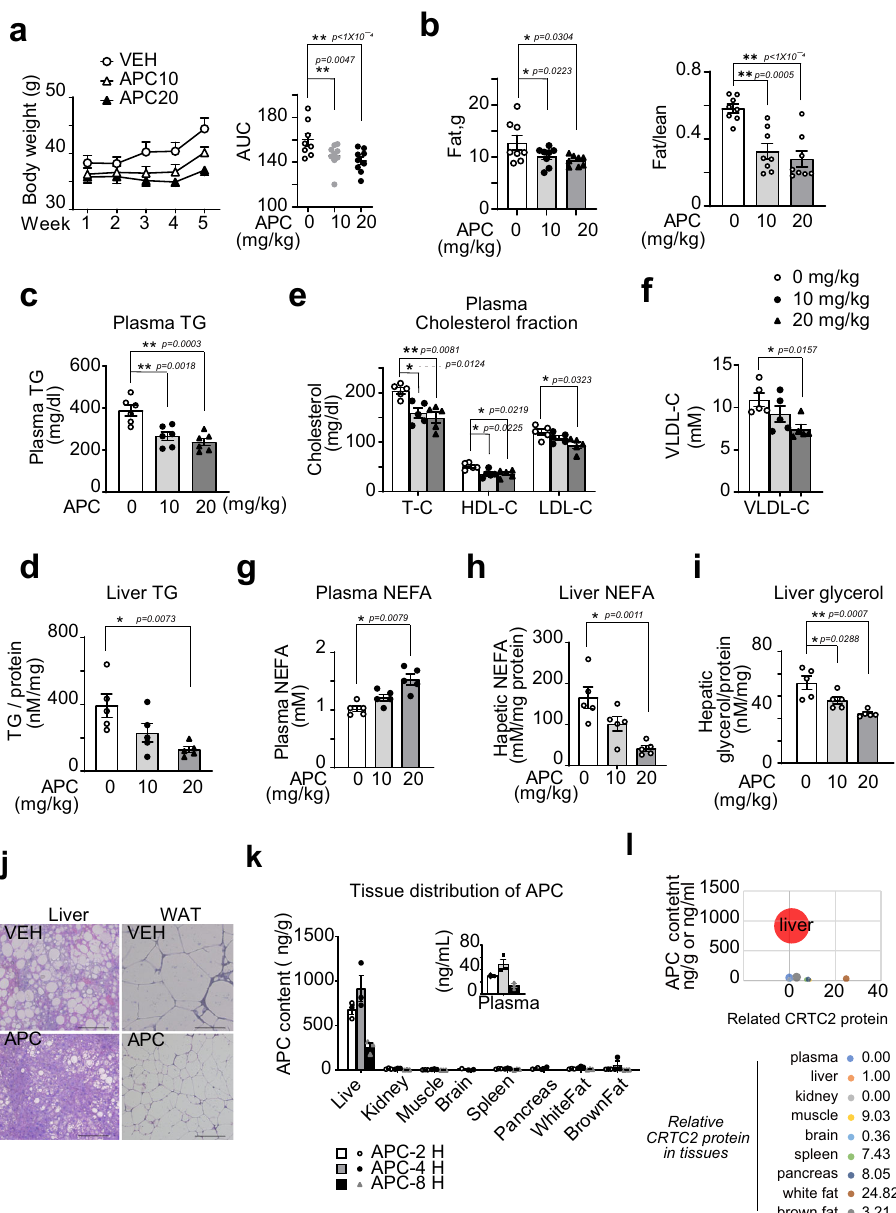
Fig. 5 APC improves hyperlipidemia of obese mice. DIO mice were continuously i.p. injected with control vehicle or APC with indicated doses (APC, 0, 10, and 20 mg/kg) or vehicle (Ctrl) one time daily for 5 weeks ( n = 5 – 9). a Body-weight curves of these mice (left). Area under curve (AUC) analysis of curves is shown as a scatter chart at the right. Data are represented as mean ± SEM ( n = 8 – 9 per group). * P < 0.05; ** P < 0.01; P values were determined by two- way ANOVA followed Bonferroni ’ s multiple comparisons test in curve analysis, or by using one-way ANOVA followed Dunnett ’ s multiple comparisons test in AUC analysis. b In vivo NMR analysis of whole-body fat mass (left) and fat composition (right, fat/lean ratio) of these mice ( n = 8 per group). Data are represented as mean ± SEM. * P < 0.05; ** P < 0.01; P values were determined by one-way ANOVA followed Dunnett ’ s multiple comparisons test. The triglyceride (TG) contents in the serum ( c ) and liver ( d ) of these mice. The contents of ( e ) total cholesterol (TC), LDL cholesterol (LDL-C), and HDL cholesterol (HDL-C), ( f ) VLDL-C, and ( g ) nonesteri fi ed fatty acid (NEFA) in the serum of these mice. h The contents of hepatic NEFA and ( i ) glycerol in these mice, which were normalized by hepatic protein levels as determined by BCA assay. Data are represented as mean ± SEM ( n = 5 – 6). * P < 0.05; ** P < 0.01; P values were determined by one-way ANOVA followed Dunnett ’ s multiple comparisons test. j Histological analysis of liver and epididymis fat (WAT) from DIO mice treated with APC (20 mg/kg) or vehicle for 5 weeks. Tissues were stained with hematoxylin and eosin. Scale bars represent 100 μ m. Here is shown one present result from three independent experiments. k The tissue distribution of APC in vivo ( n = 3 per group, data are represented as mean ± SEM). Two to 8-h after one oral dose (20 mg/kg), the APC content in indicated tissues of C57BL6 was detected by a liquid chromatography-mass spectrometry/mass spectrometry (LC – MS/MS) and normalized by protein concentration. l Combination analysis of APC concentration and relative CRTC2 protein level in tissues. Taking the APC concentration (4-h after p.o.) as the Y axis, the relative content of CRTC2 as the X axis, and the APC content as the size of bubbles, each tissue was projected on the graph (top). The relative density of CRTC2 protein of indicated tissues was corrected to TUBULIN and normalized with that in the liver (as base) (bottom, and associated with Supplementary Fig. 4h). Source data for this fi gure are provided as source data fi le.